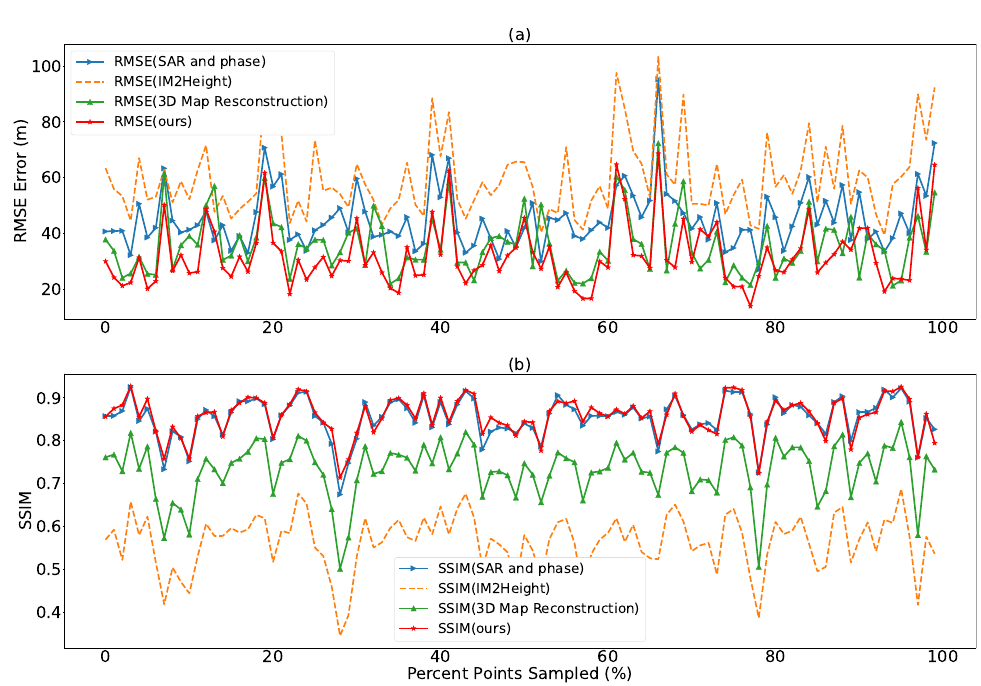
Figure 10. ( a ) RMSE and ( b ) SSIM of SAR&phase, IM2HEIGHT, 3D map reconstruction and ours on 132 unique 256 × 256 local patches of the test scene with downsampling factors of 96 ×